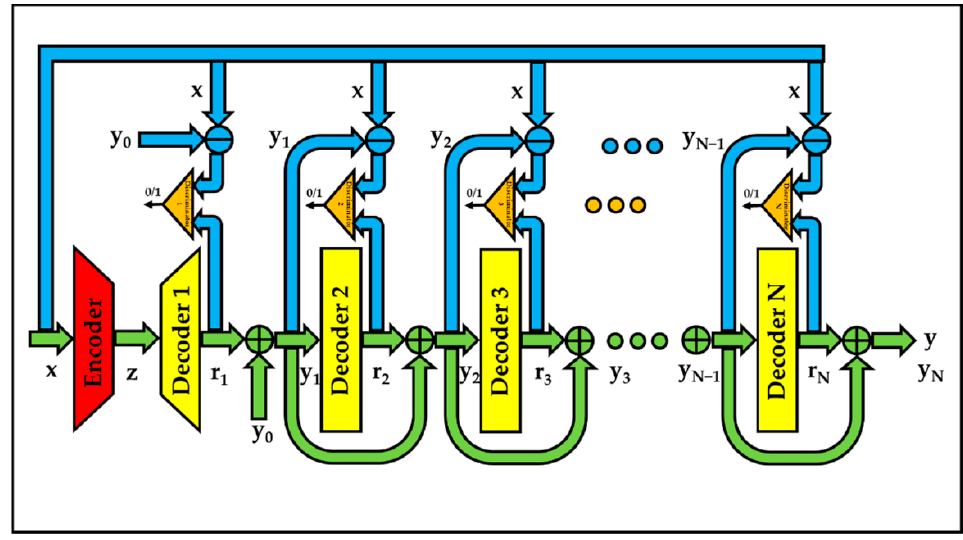
The framework of residual-adversarial cascade decoders-based auto-encoders (RAC- DAE) is shown in Figure 6. The blue signal line denotes the training phase, and the green signal line denotes both phases of training and testing. Each decoder is a residual- adversarial module.